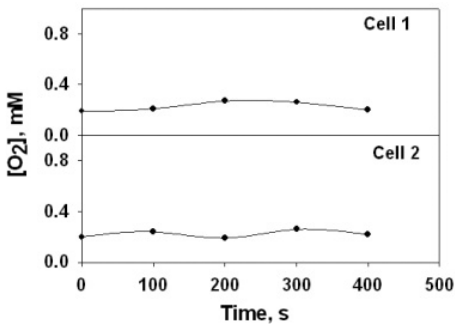
Fig. 10. Estimation of oxygen concentration in single HDF cells (equibrated in air) as a function of time. Phosphorescence from the entire cell was collected in these estimations made every 100 s. Time 0 refers to collection during 0 – 100 s and so on. Reproduced with permission from Williams et al.